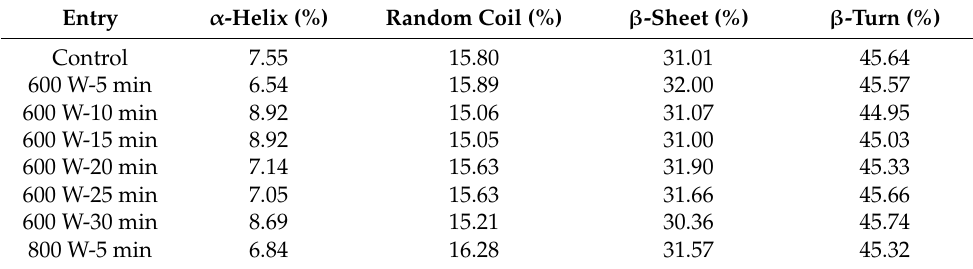
Table 2. Effects of HIU treatment on the secondary structure composition of